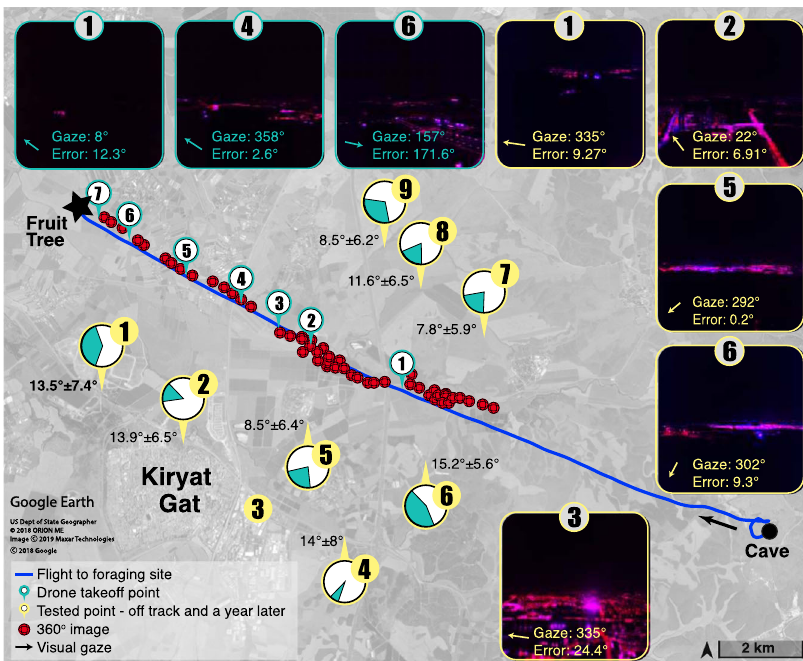
Fig. 1 Navigation-net can explain visual animal navigation. The blue line shows the bat ’ s actual trajectory from its cave (black circle) to its target tree (black star). Red spheres show points where the drone collected 360° images (the drone took off at green points 1 – 7). Images with green frames show three examples of input-images with the actual (allocentric) direction in which they were taken, i.e., the gaze relative to the target (solid arrow) and the output error in degrees relative to the target. The error is depicted in the image. Gaze angles are given using a 0 – 360° clockwise notation with 0° pointing toward the fruit tree target. The fi gure also shows the locations where 360° images were taken a year later to test generalization (yellow points 1 – 9) with the region where the network performed well shown in green and the error in degrees given for these green sectors. Five example input images taken in the yellow points are shown on the right side (yellow frame) with the gaze and error angles depicted on them too. Note that in point 3 the navigation-net was not able to point toward the direction of the target with an error of less than 24° at all. The satellite image was obtained from Google Earth,